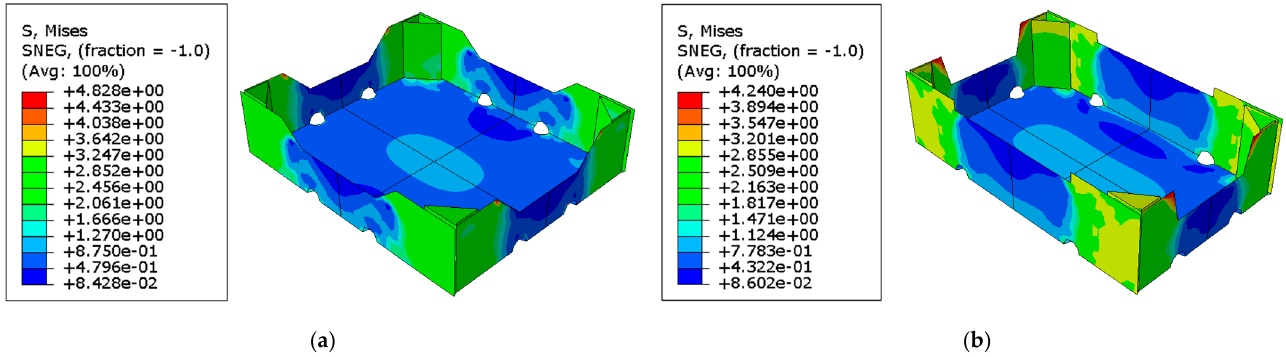
Figure 5. Distribution of effective Huber–Mises–Hencky stresses at the moment of reaching the maximum strength of the fruit tray: ( a ) case 19 and ( b ) case 20.